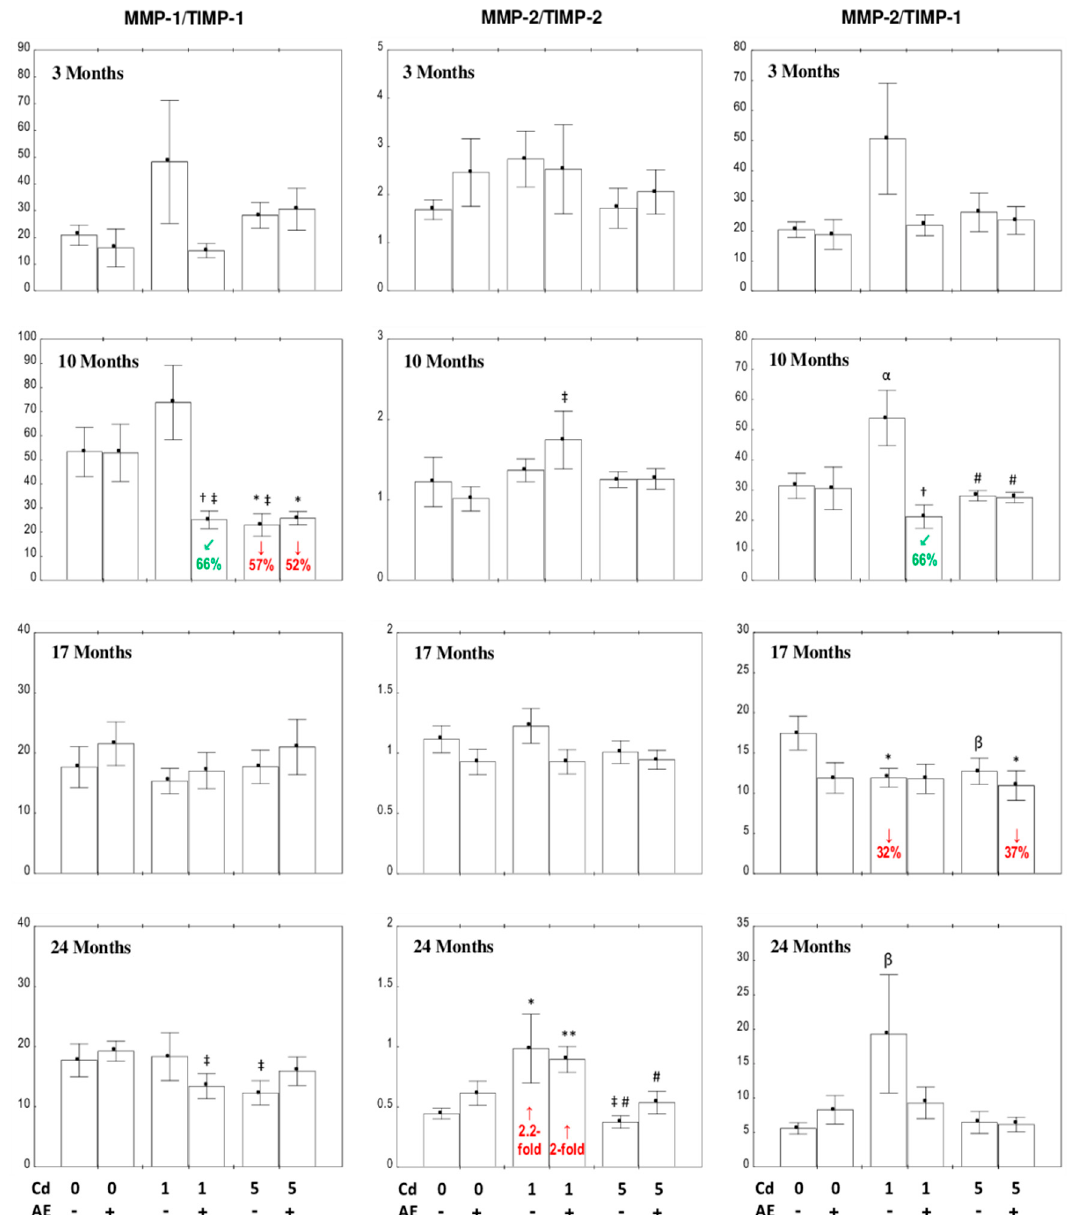
Figure 8. The impact of Aronia melanocarpa L. berry extract (AE) on the ratios of matrix metalloproteinase-1 (MMP-1) / tissue metalloproteinase inhibitor-1 (TIMP-1), matrix metalloproteinase-2 (MMP-2) / tissue metalloproteinase inhibitor-2 (TIMP-2), and MMP-2 / TIMP-1 in the livers of rats exposed to cadmium (Cd). The animals were treated with Cd at the concentrations of 0, 1, and 5 mg Cd / kg in their diets and / or 0.1% aqueous AE ( + ) or not ( − ). Data are shown as mean ± SE for eight rats, except for seven animals in the AE, Cd 1 , and Cd 5 groups after 24 months. Statistically significant differences (Kruskal–Wallis post hoc test): * p < 0.05, ** p < 0.01, α p < 0.06, and β p < 0.08 vs. control group; † p < 0.05 vs. appropriate Cd group; ‡ p < 0.05 vs. AE group; # p < 0.05 vs. appropriate group maintained on the 1 mg Cd / kg diet (Cd 1 group or Cd 1 + AE group). Numerical values in bars express the percentage changes or factors of changes in comparison to the control group ( ↑ , increase; ↓ , decrease) or the appropriate group exposed to Cd alone ( ↙ , decrease).